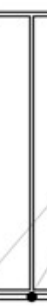
Figure 12. Crane beam deflection during the crane crab passage.